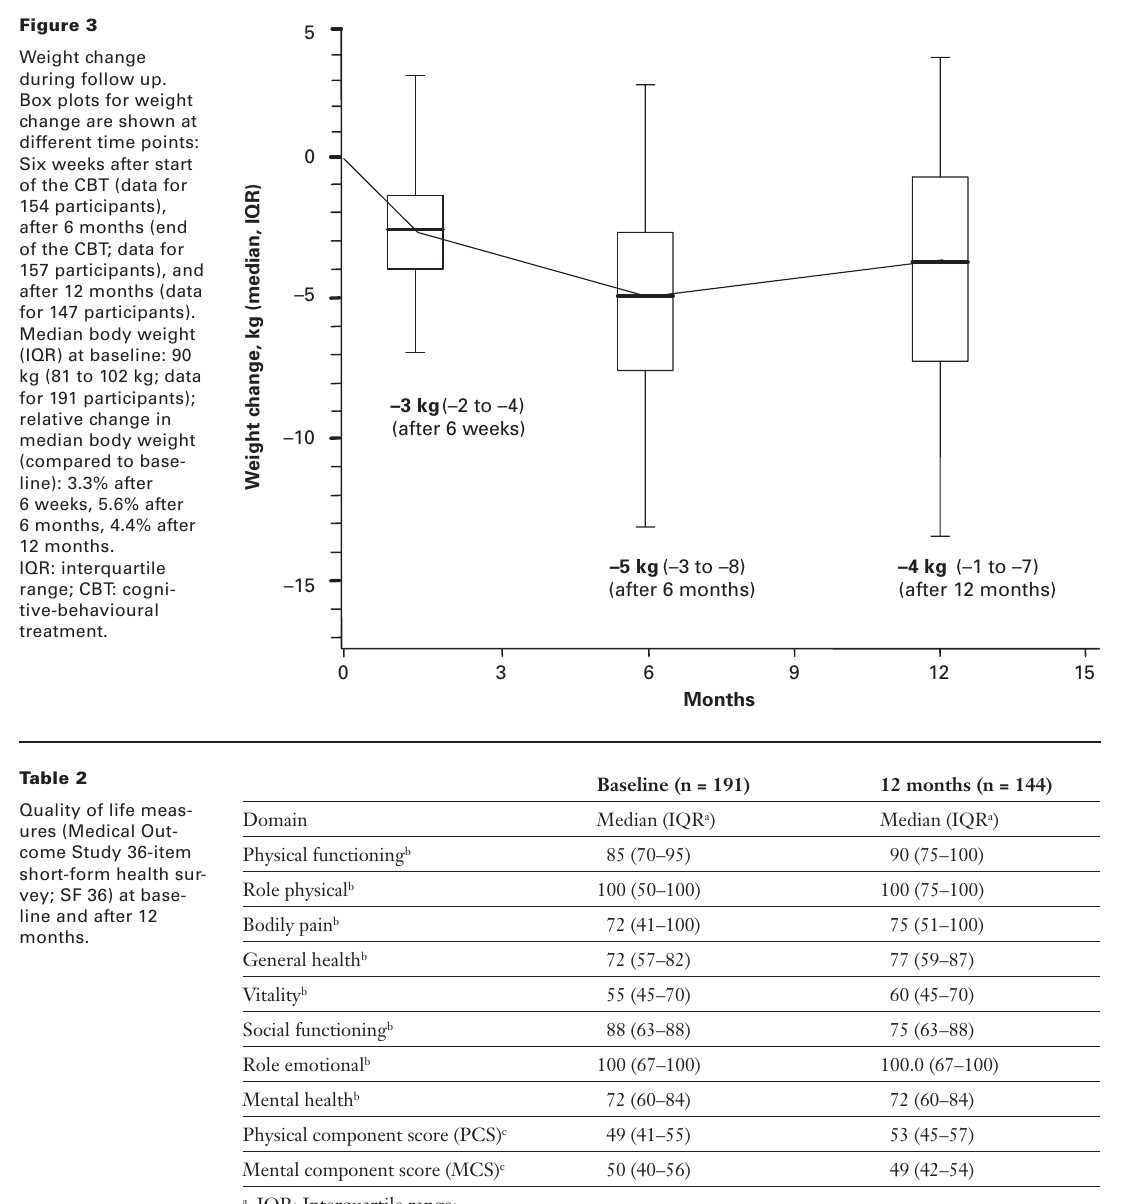
Quality of life meas- ures (Medical Out- come Study 36-item short-form health sur- vey; SF 36) at base- line and after